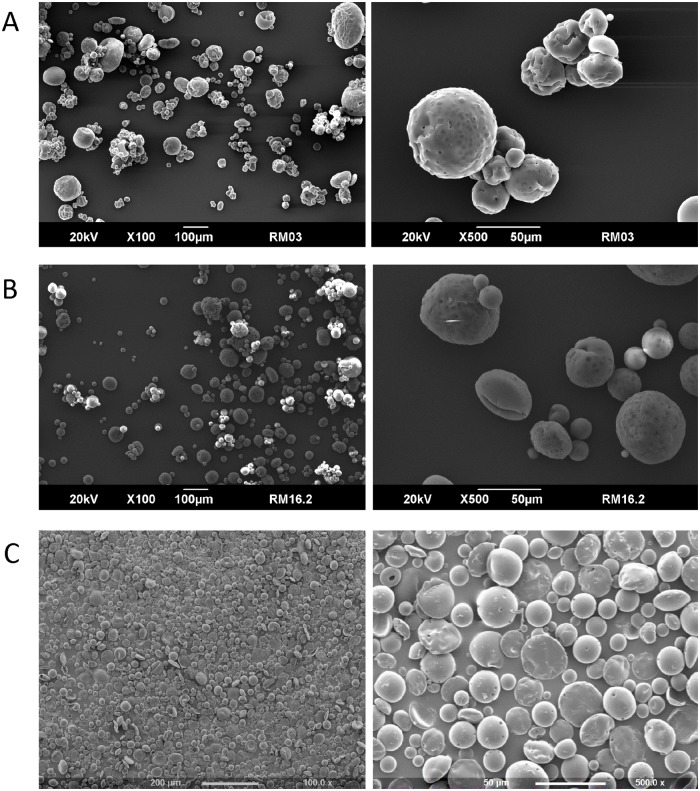
SEM images of PLGA MP formulated by (A) run 3 from L12 OA design and (B) run 16 from L18 OA design (optimal model formulation) and (C) BSA-loaded PLGA MP.